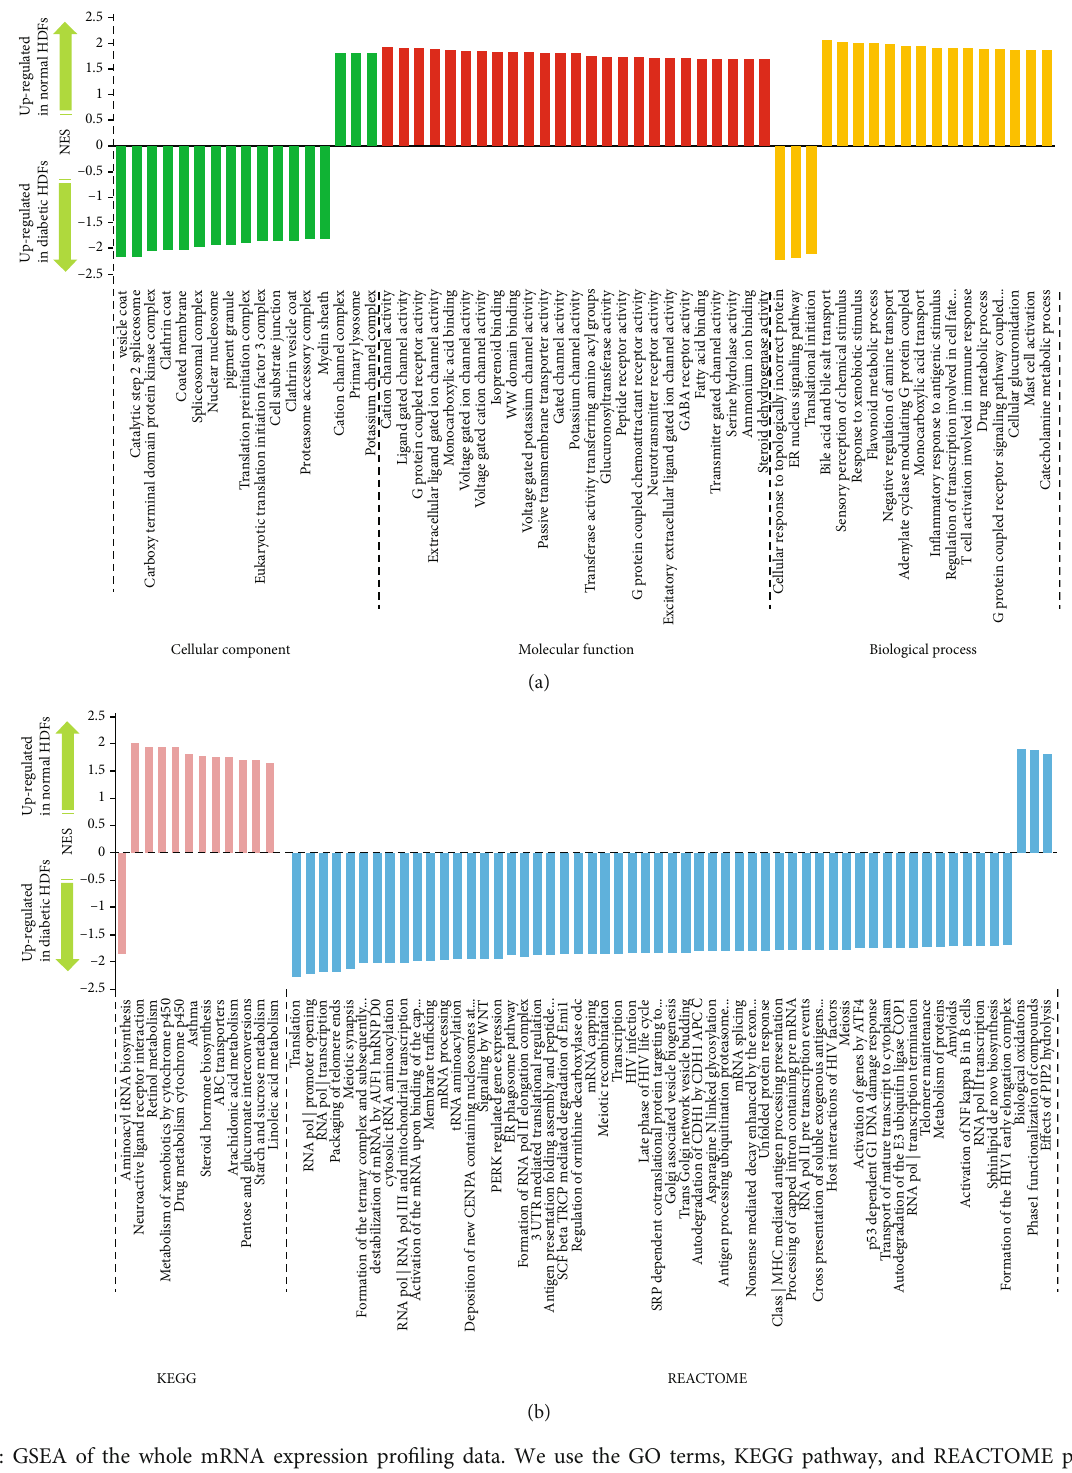
Figure 4: GSEA of the whole mRNA expression pro fi ling data. We use the GO terms, KEGG pathway, and REACTOME pathway as prede fi ned gene sets. Gene sets with FDR < 0 : 05 were considered signi fi cantly enriched. (a) Signi fi cantly enriched gene sets relating to GO terms in GSEA. (b) Signi fi cantly enriched gene sets relating to the KEGG and REACTOME pathways in GSEA. NES: normalized enrichment score. Generally, the greater absolute value of NES means that the expressions of genes in the gene set are more accordantly changed in experimental conditions. The positive NES value indicates higher expression of gene sets in the normal group. The negative NES value indicates higher expression of gene sets in the diabetic